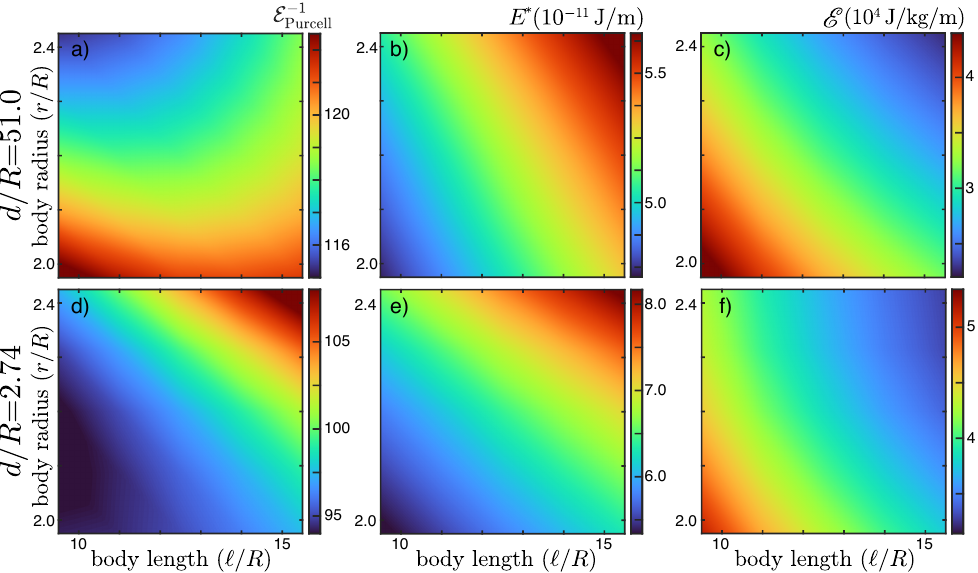
Figure 13. Comparison of Purcell inefficiency, energy per distance, and metabolic energy cost with respect to body geometry at the typical wavelength of E. coli ( λ / R = 11.1). The top row shows results far from the boundary ( d / R = 51.0) and the bottom row shows results near the boundary ( d / R = 2.74). In panels ( a , d ), the Purcell inefficiency shows that short, thick bodies are most efficient (i.e., least inefficient) far from the boundary, but short, thin bodies are most efficient near the boundary. In panels ( b , e ), short, thin bodies require the least energy cost per distance both far from and near the boundary. In panels ( c , f ), long, thick bodies require the least metabolic energy cost per distance traveled both far from and near the